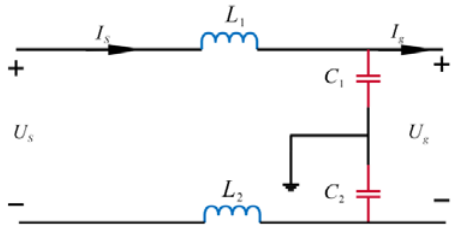
Figure 15. Topology for an LC common-mode filter.